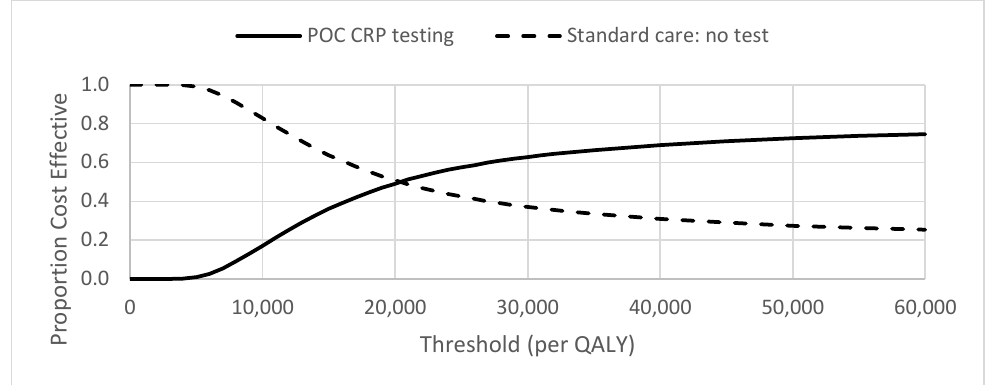
Figure 1. Cost-effectiveness plane for pragmatic use of POC CRP testing.